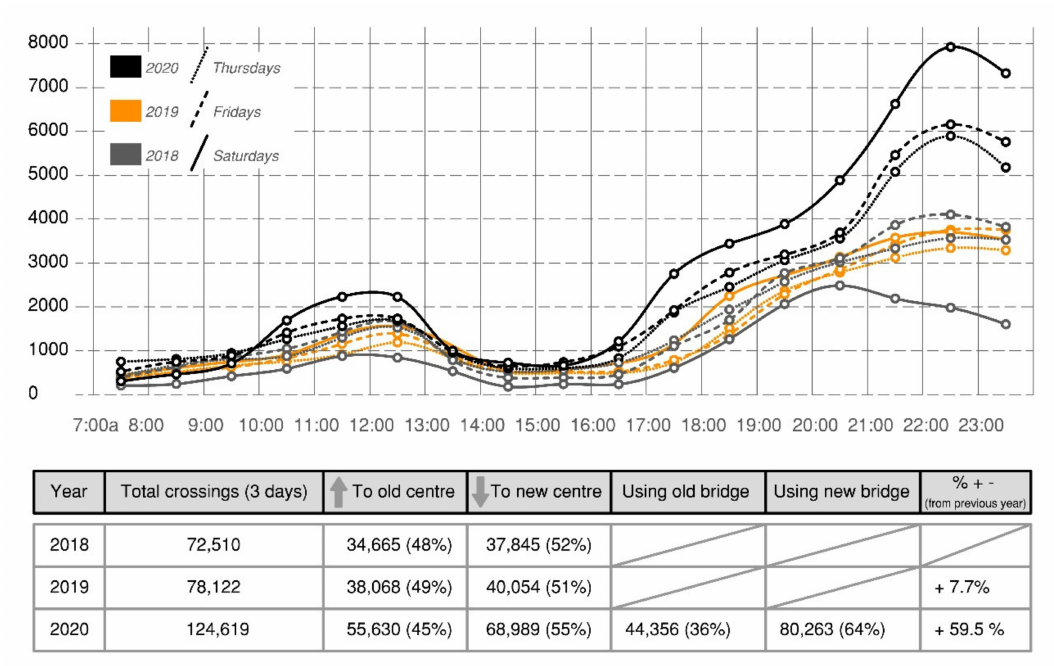
Figure 15. Periods of activity relate to summer temperatures, decreasing during the hot afternoons and increasing during the nights, and well into the next